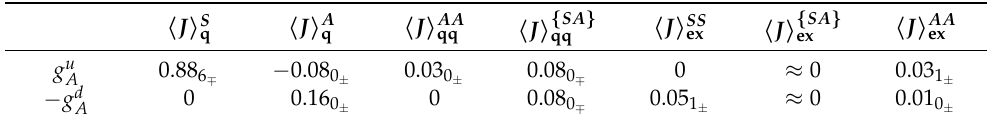
Table 3. Flavour and diagram—Figure 14—separation of the proton axial charge: g u = G d ( 0 ) ; g u − g d = 1.25 ( 3 ) . The listed uncertainties express the effect of ± 5% variations in the g d A A A A ⇒ 0.88 ∓ diquark masses, e.g., 0.88 6 ∓